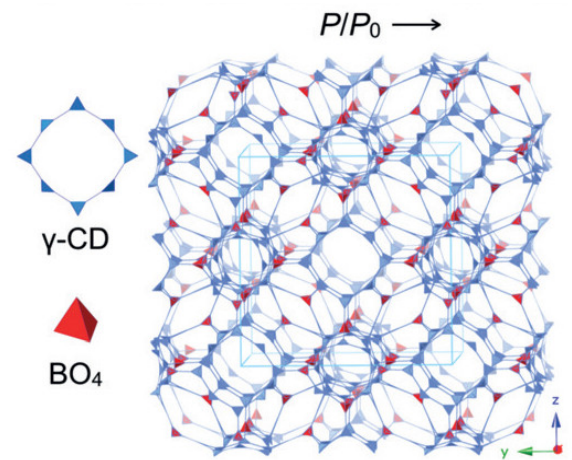
Figure 21. Synthesis of CD-COF-Li